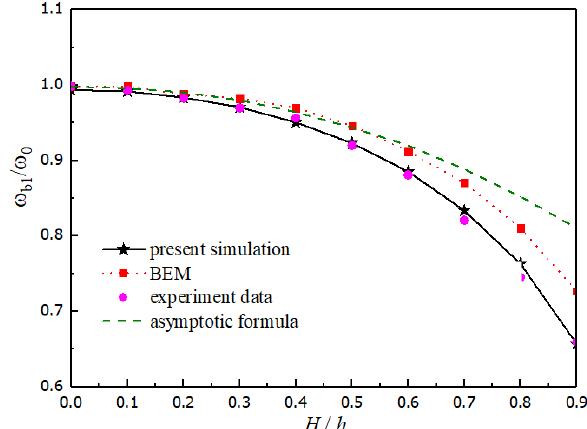
Figure 7. Comparison of the natural frequency of sloshing in a tank ( L = 0.6 m, h = 0.3 m) under different baffle heights between the results of the present simulation, BEM results of Firouz-Abadi [38], experimental data of Wu et al. [37] and asymptotic formula of Faltinsen and Timokha [2].